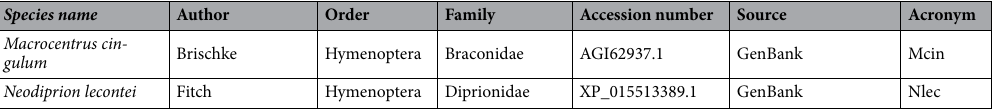
Table 1. Acronyms of the Orco polypeptide sequences. Acronyms are reported in the analysed dataset (Supplementary dataset file), among figures and in the text. Accession number of polypeptide sequences and sources are